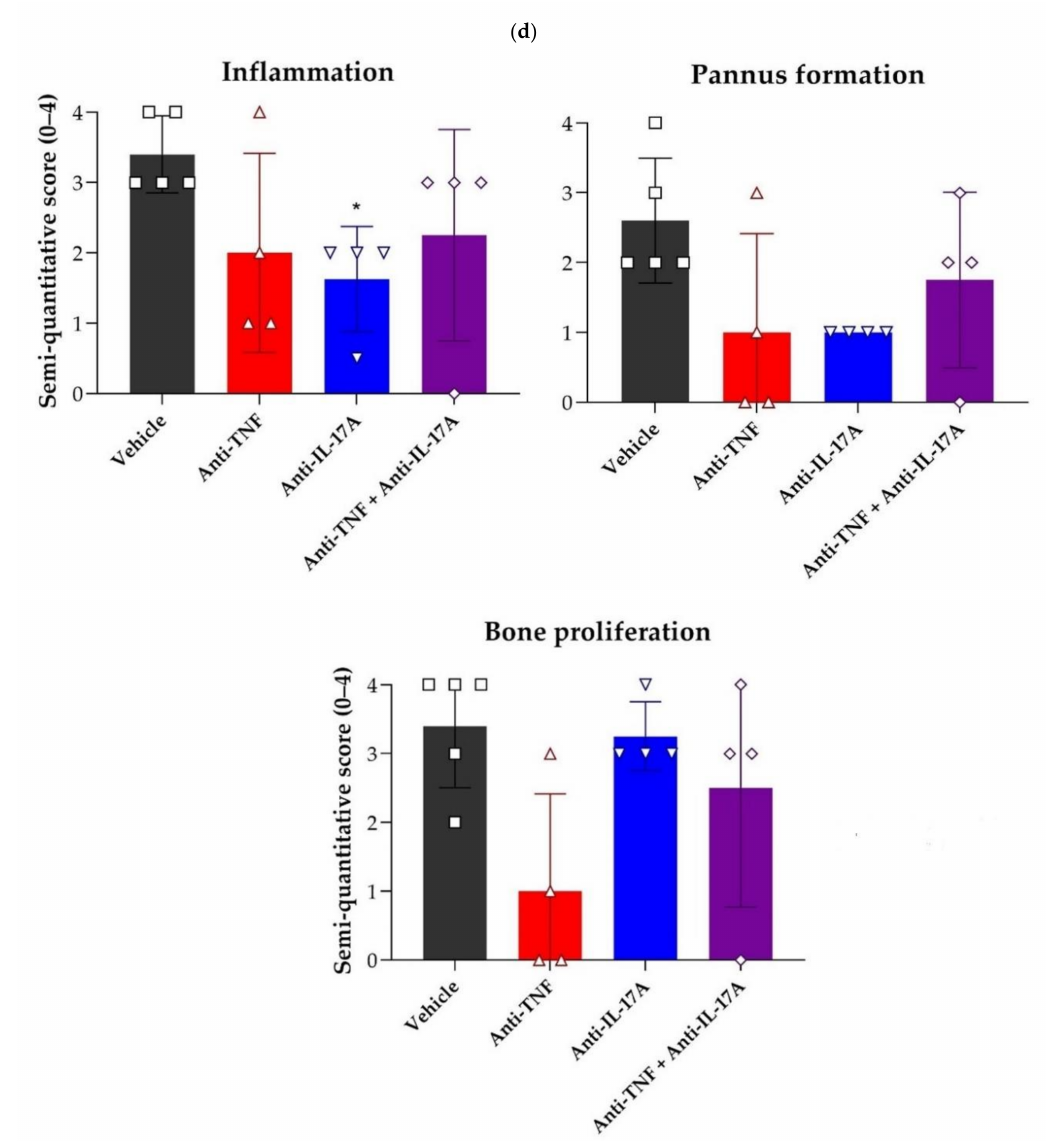
Figure 2. TNF and IL-17A dual blockade therapy reduces inflammation and bone proliferation in the axial and peripheral joints. ( a ) Representative caudal spine sections stained for hematoxylin and eosin (H&E) for rats who were treated with anti-TNF and anti-IL-17A (8C11 and B6-17, n = 4), anti-TNF (8C11, n = 4–5), anti-IL-17A (B6-17, n = 4), or vehicle control ( n = 5). ( b ) Experimentally blinded semi-quantitative scoring (0–4) of inflammation, pannus formation and bone proliferation of histologically stained caudal spine sections showed significant decreases of inflammation for dual blockade ( p = 0.036) and anti-TNF ( p = 0.039). Pannus formation was significantly reduced for all treatments compared to vehicle control (anti-TNF, p = 0.016; anti-IL17A, p = 0.021; dual blockade, p = 0.037). A numerical decrease of bone proliferation was seen for all treatment modalities compared to vehicle control. ( c ) Representative ankle sections stained for H&E for the three different treatment modalities and vehicle control. ( d ) Experimentally blinded semi-quantitative scoring (0–4) of histologically stained ankle sections showed a significant decrease for inflammation for anti-IL17A ( p = 0.047) compared to vehicle control. *, p ≤